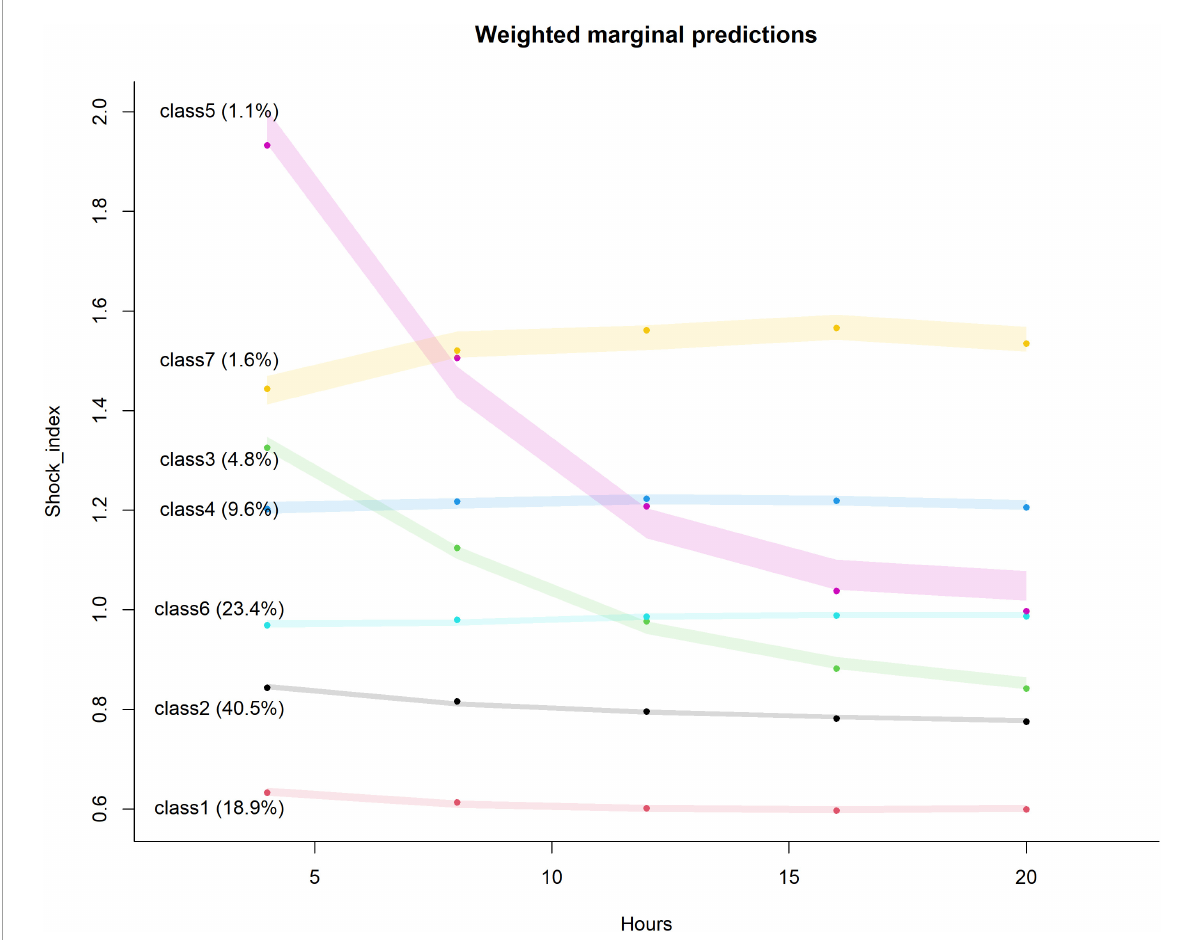
FIGURE3 Seven classes identified by trajectories of shock index. The shaded area indicates the 95% confidence interval for each mean trajectory. The percentages in the parentheses indicate the percentages of patients each class accounts for.